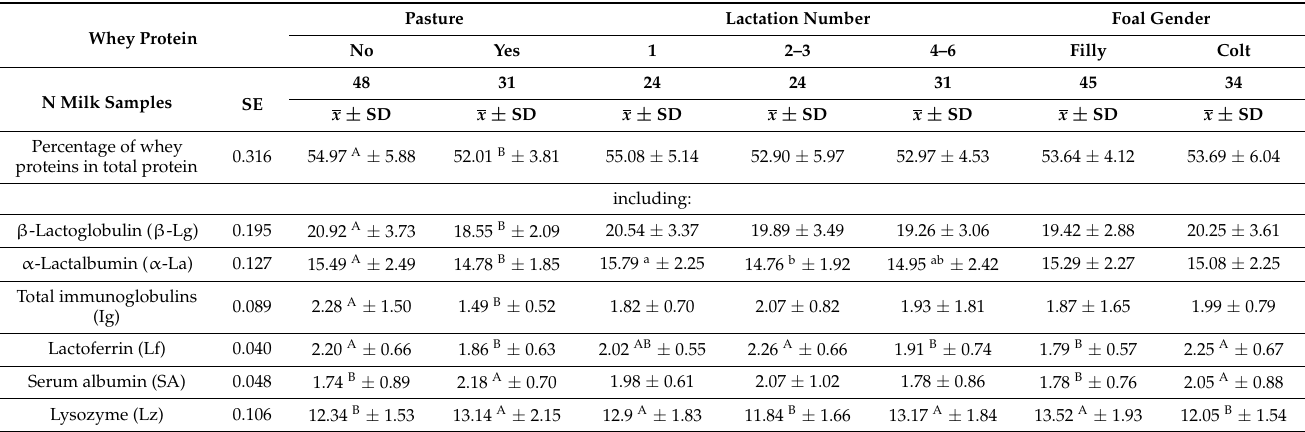
Table 3. Whey protein profile in horse milk (% of total